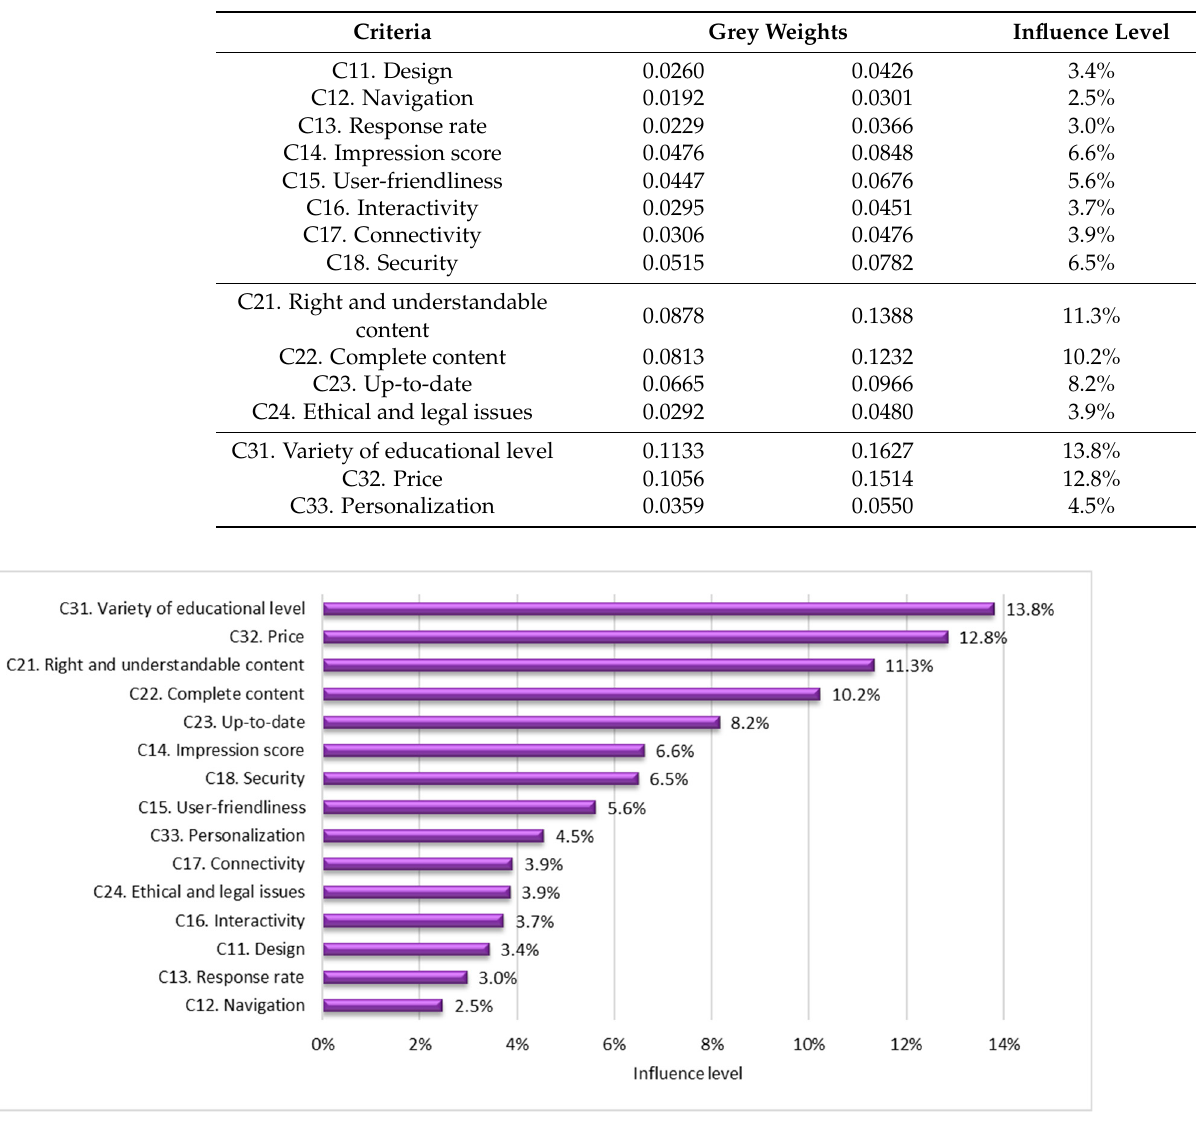
Figure 3. The influence level of criteria from the G-AHP model.